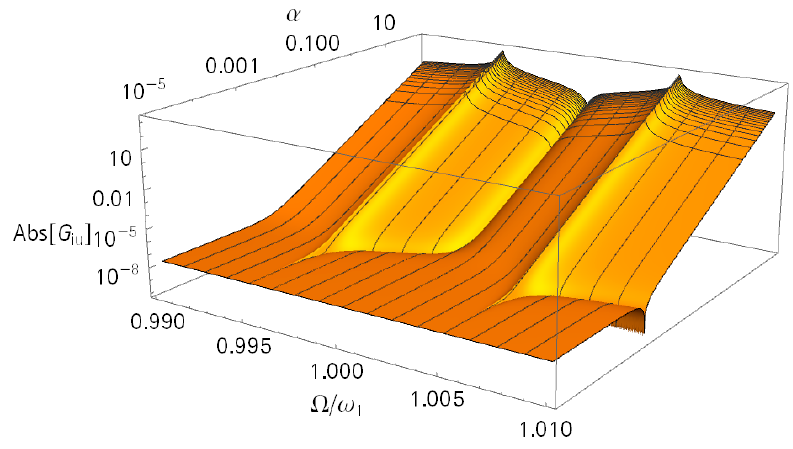
Figure 7. Magnitude of the admittance ( G iU ) for varying α values. The used parameters were m = 1 kg; m n = 0; k = 10 N/m; M = m / κ ; k M = k / κ ; κ = 10 − 4 ; D = d M = 5 × 10 − 4 Ns/m; C p = 10 nF; and α = 0.1 N/V.